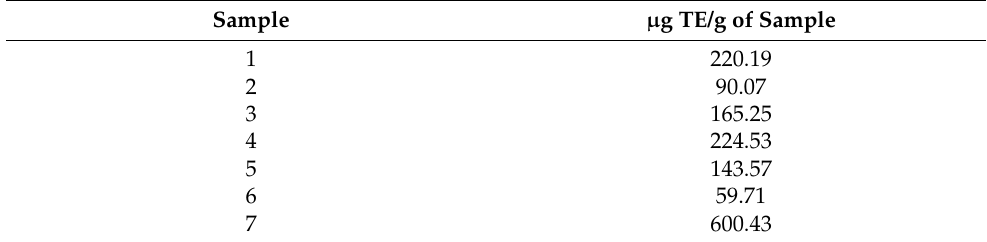
Table 11. Results expressed in µ g TE/g of sample (FRAP method).